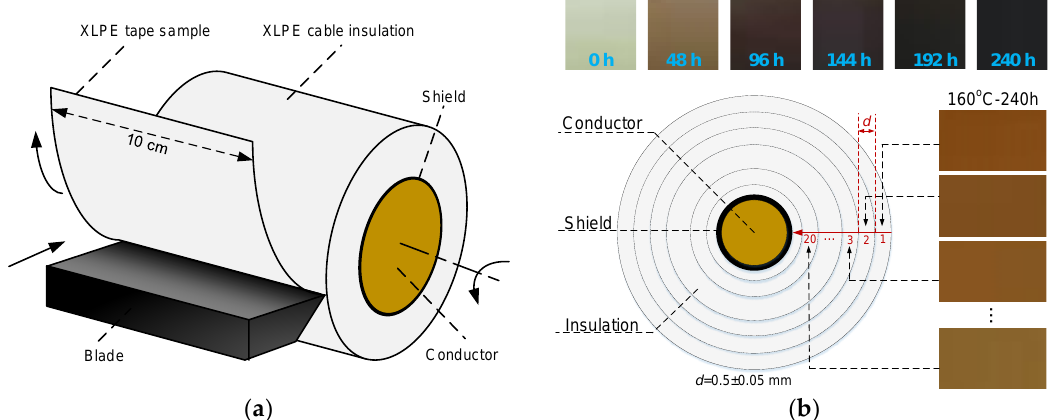
Figure 1. ( a ) The schematic diagram of cutting method; ( b ) the distribution of cross-linked polyethylene (XLPE) at different positions. The top is the surface color of the cylinder samples and the right is the color of the sheet samples.